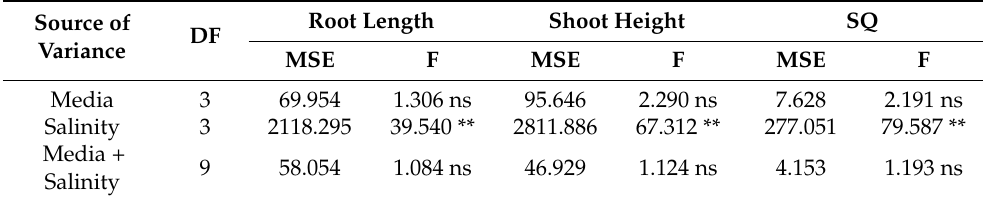
Table 2. Effect of medium composition and water salinity on root length, shoot height (cm), and sturdiness quotient (SQ) of 14 week old Avicennia marina (Forssk.) Vierh. seedlings.